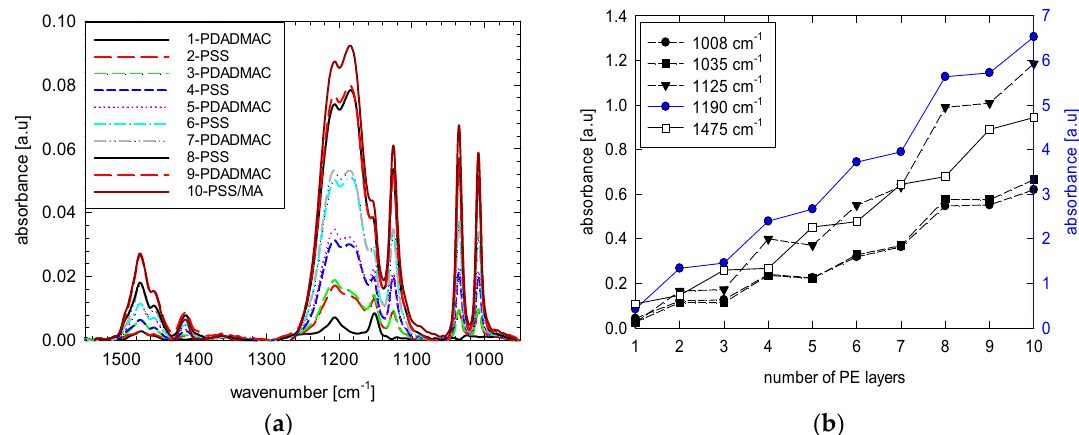
Figure 5. ( a ) An example of the FTIR spectra obtained at the consecutive steps of the formation of (PDADMAC/PSS) 4 PDADMAC multilayer film on the surface of Ge crystal, followed by the adsorption of unmodified PSS/MA; ( b ) changes in the intensity of the fingerprint bands of PSS and PDADMAC upon the formation of the multilayer film.